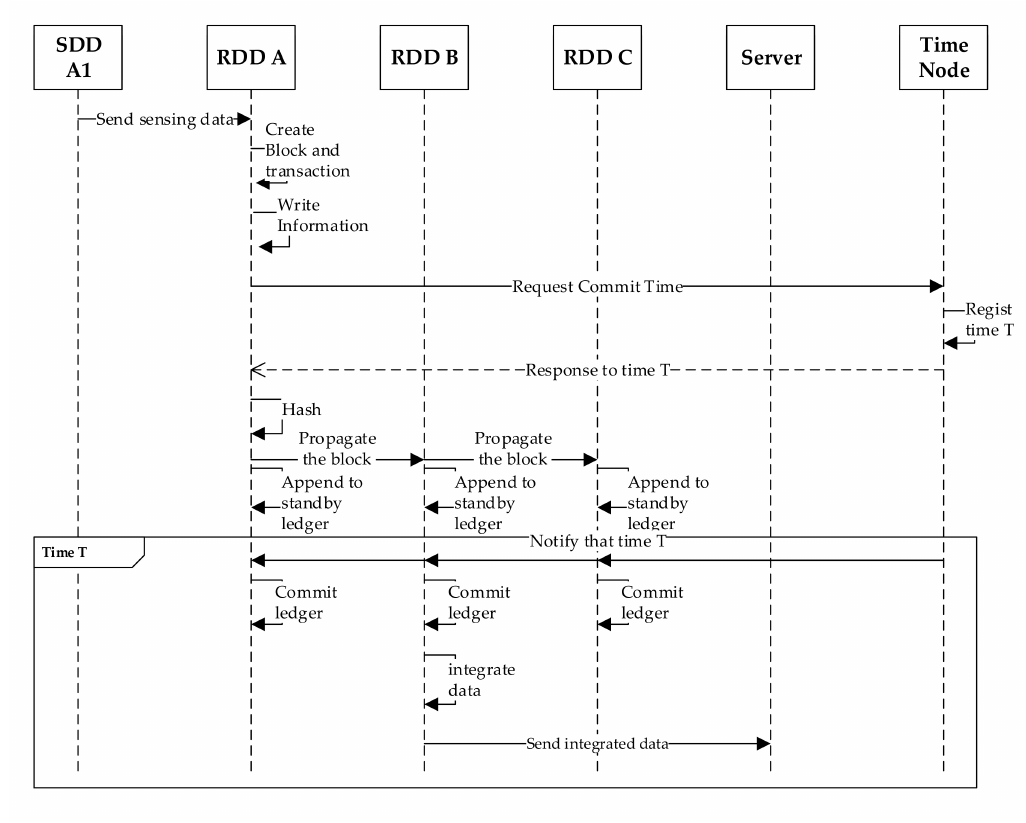
Figure 3. A sequence diagram for the normal data blockchain processing